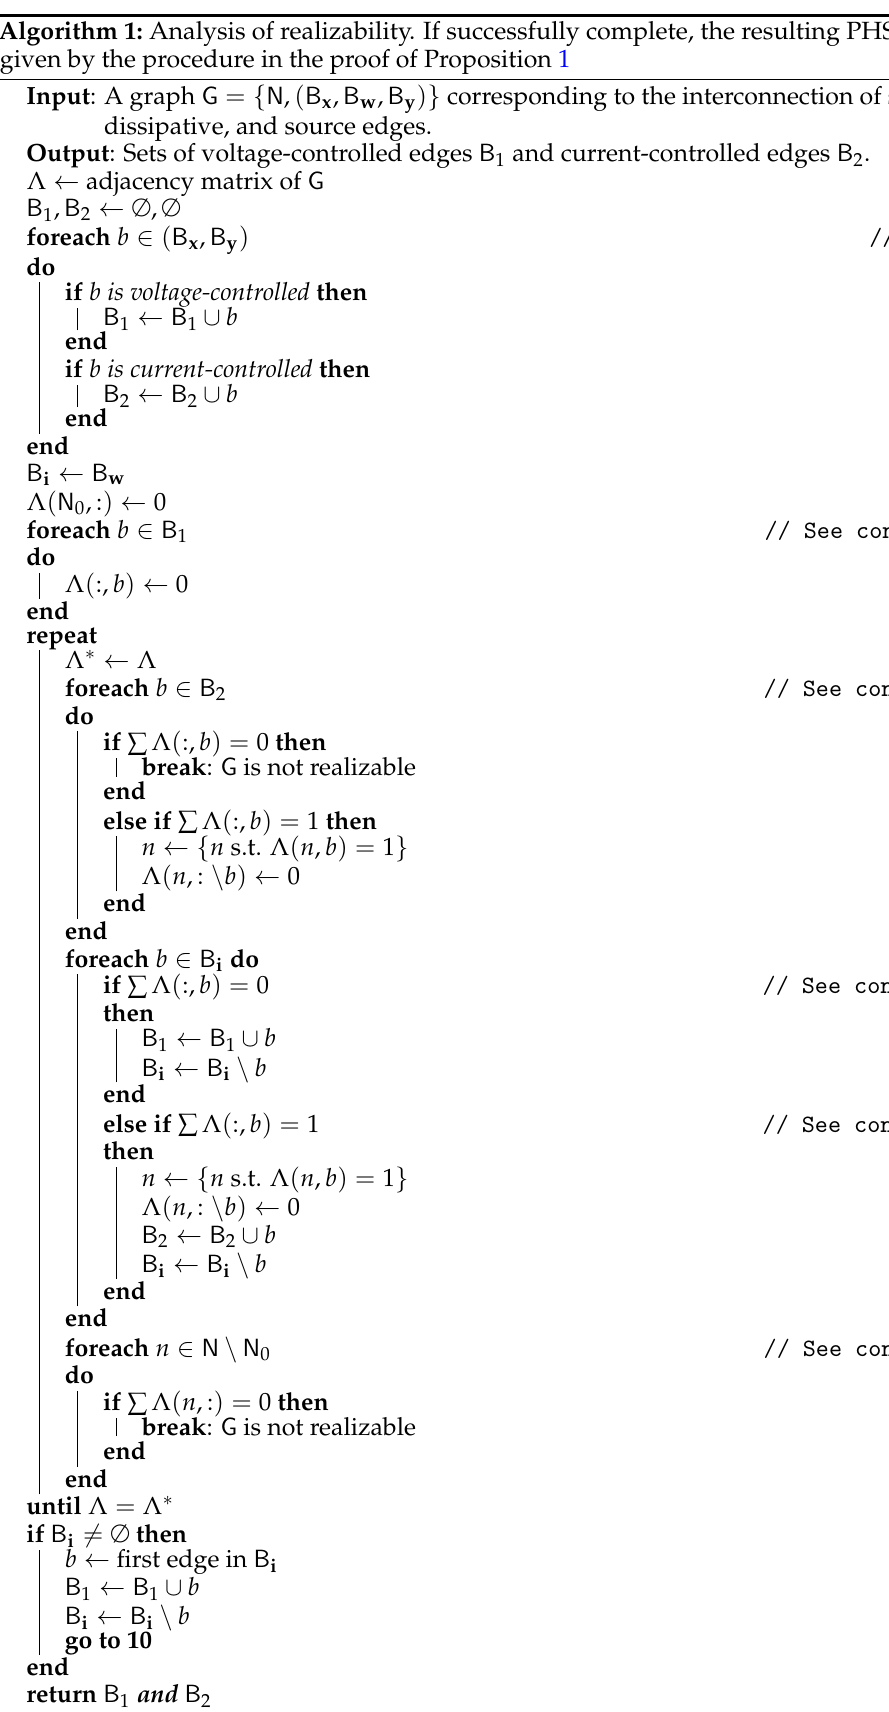
Algorithm 1: Analysis of realizability. If successfully complete, the resulting PHS structure is given by the procedure in the proof of Proposition